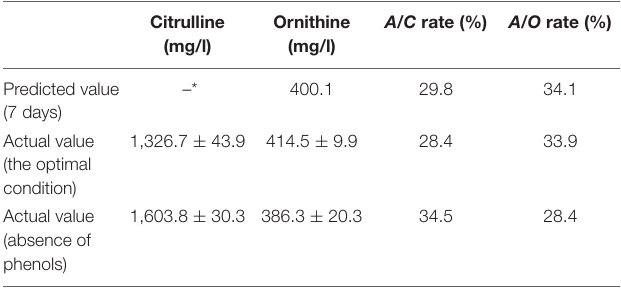
TABLE 3 | The relationship between predicted value and actual value of simulated moromi ( n = 3). Citrulline Ornithine (mg/l)